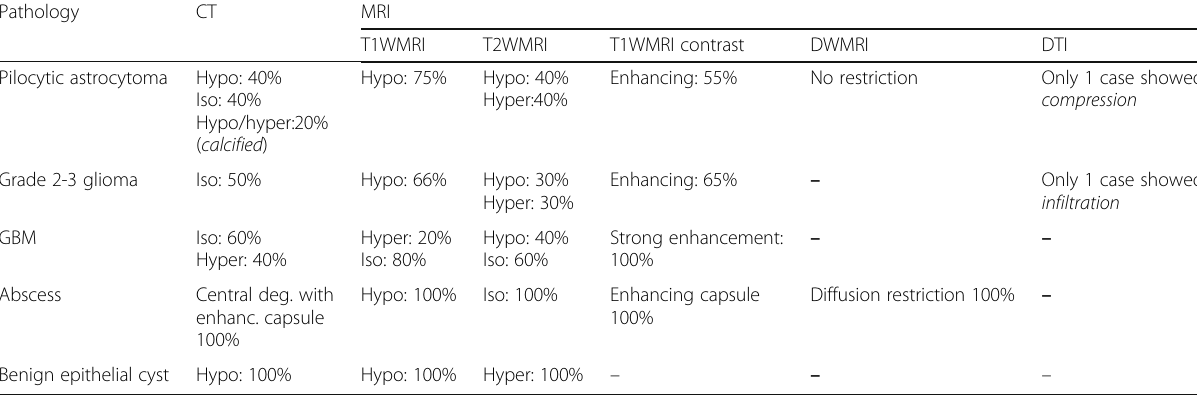
Table 2 Imaging criteria of different pathologies Pathology